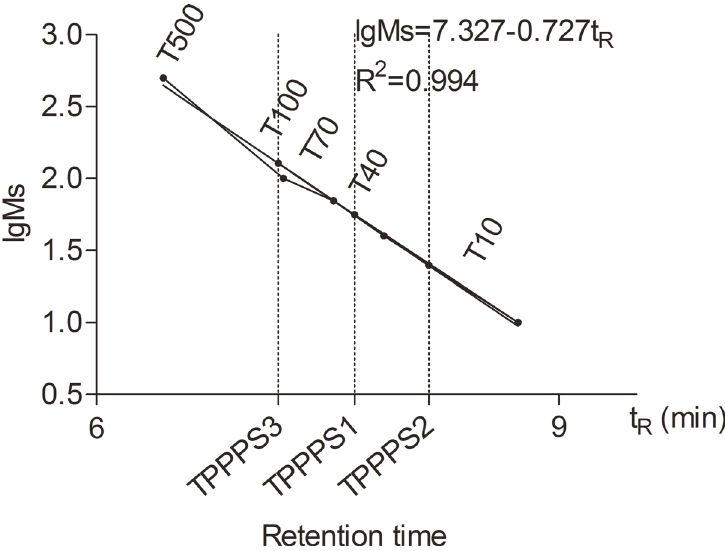
Fig 2. Mw determination with HPGPC system for TPPPS1-3. The standard curve was calibrated with T- series dextran (T-500, T-100, T-70, T-40, and T-10) as standard. lgMs = 7.327 – 0.727 t R , R 2 = 0.994. lgMs was defined as the logarithm of the Mw, and t R was the retention time. The molecular weight of TPPPS1-3 was estimated by the standard calibration curve.